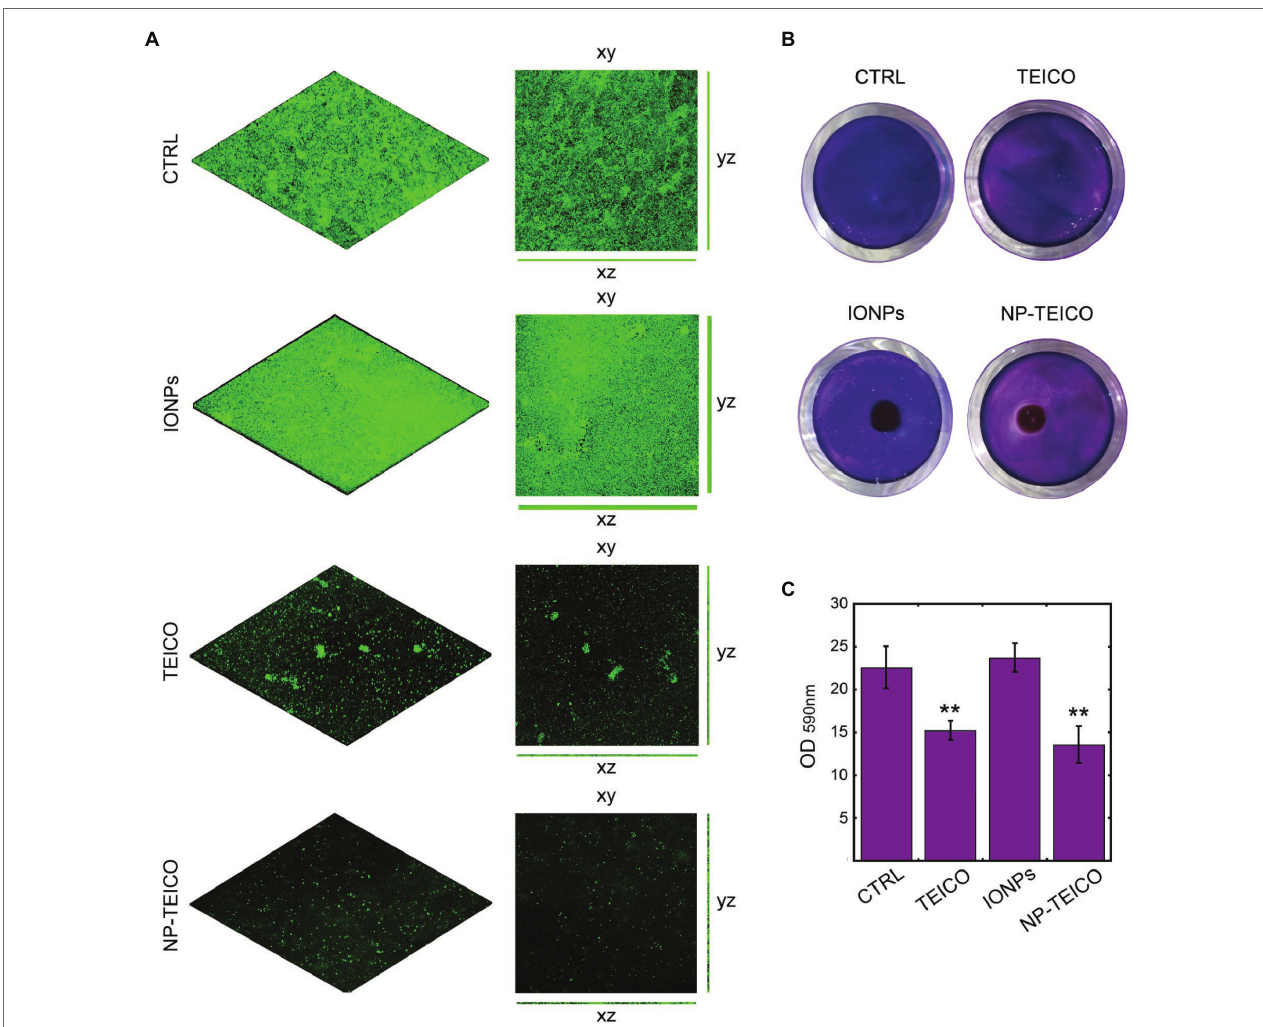
FIGURE 4 | Effect of nonconjugated and nanoconjugated teicoplanin on S. aureus ATCC 6538P biofilm on different surfaces. Panel A : CLSM images of S. aureus ATCC 6538P biofilm on glass surface, grown for 24 h without any addition (CTRL) or in the presence of nonconjugated (TEICO) or nanoconjugated (NP-TEICO) teicoplanin at 4 μ g/ml, or with an equivalent amount of IONPs. Panel B : S. aureus ATCC 6538P biofilm formation in 24-well polystyrene plate, exposed to a magnet (5 × 5 × 5 mm) localized under each well. The bacteria were grown 24 h on the plastic surface in different conditions: without any treatment (CTRL), incubated with nonconjugated teicoplanin (TEICO) or with nanoconjugated teicoplanin (NP-TEICO) added in both cases at 1 μ g/ml, or with an equivalent amount of IONPs. Panel C : Adherent biomass formation in 24-well polystyrene plate after 24 h of bacterial growth at 37 ° C, quantified spectrophotometrically at 590 nm after crystal violet staining. Statistical analyses were performed by one-way ANOVA (** p <